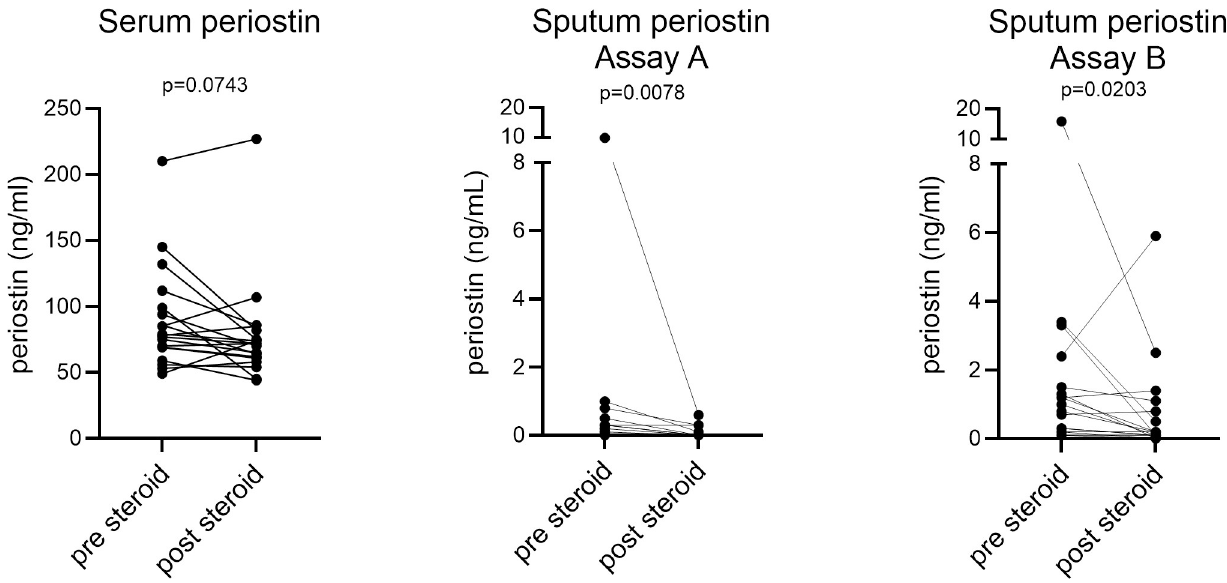
Fig 4. Effect of oral corticosteroid treatment on serum and sputum periostin. Periostin levels in matched serum and sputum samples were measured before and after 2 weeks of treatment with oral prednisolone. Paired comparisons by Wilcoxon matched-pairs signed rank test were possible for n = 20 patients with mild-to-moderate and severe asthma from the BIOAIR study.